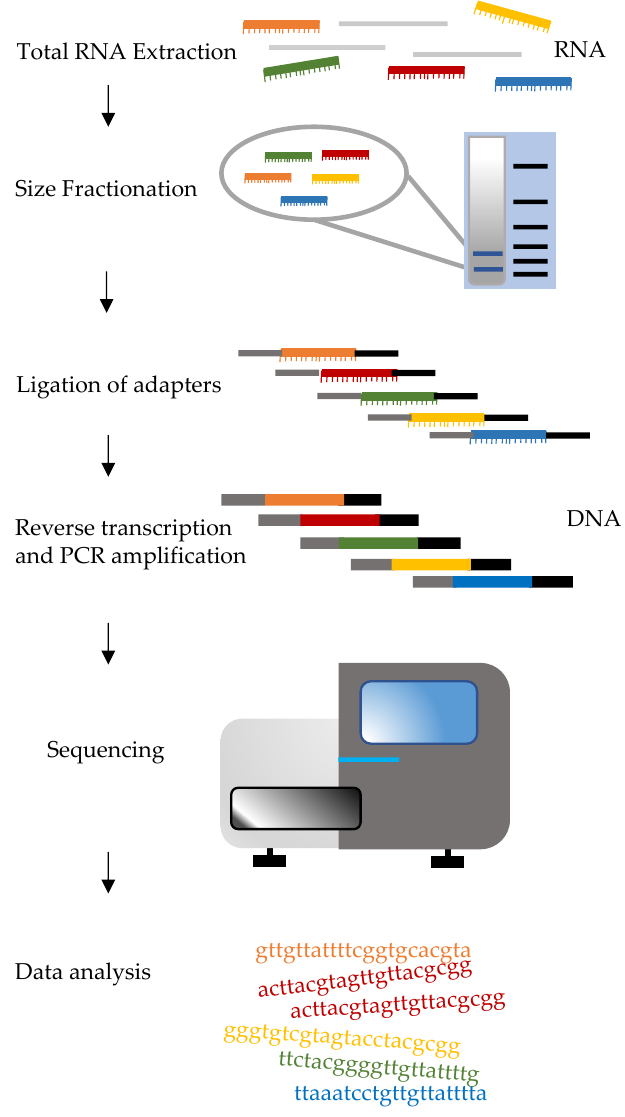
Figure 6. Diagram of small RNA Sequencing workflow. For the sake of simplicity, only five small RNA types are indicated (colored miRNAs). However, this technology has the potentiality to detect several thousands of different small RNA molecules, irrespective of whether they are known or they have never been described. Details of the experimental steps vary depending on the library preparation method and on the NGS platform